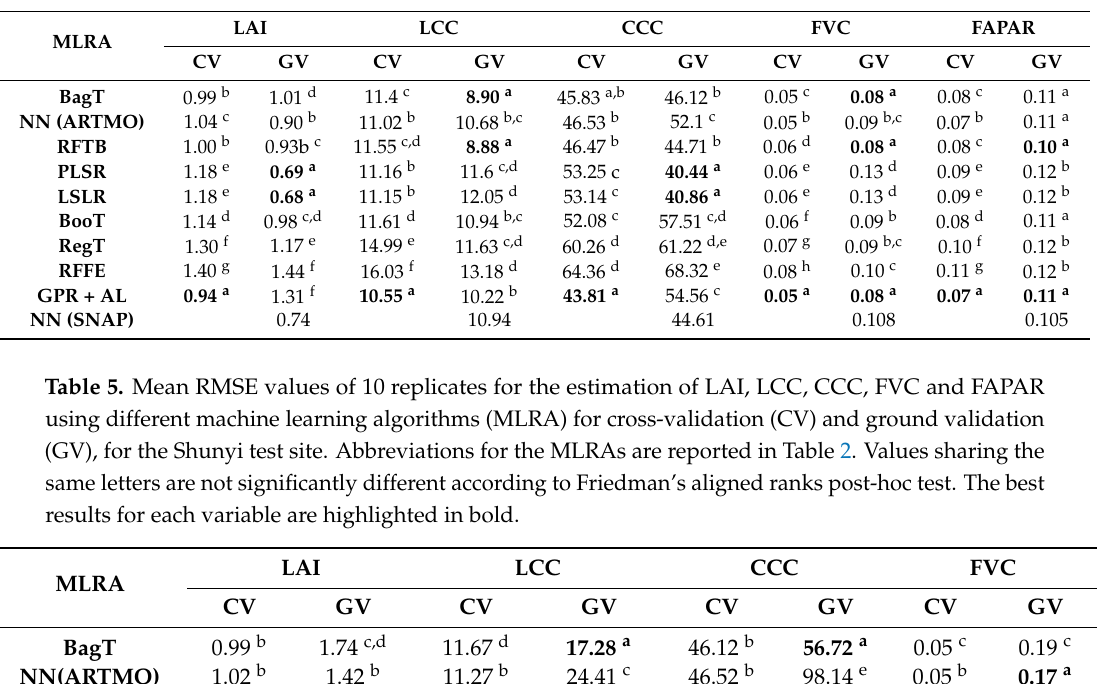
Table 4. Mean RMSE values of the 10 replicates for the estimation of LAI, LCC, CCC, FVC, and FAPAR using different machine learning algorithms (MLRAs) for cross-validation (CV) and ground validation (GV), for the Maccarese test site. Abbreviations for the MLRAs are reported in Table 2. Values sharing the same letters are not significantly different according to Friedman’s aligned rank post-hoc test. The best results for each variable are highlighted in bold. MLRA